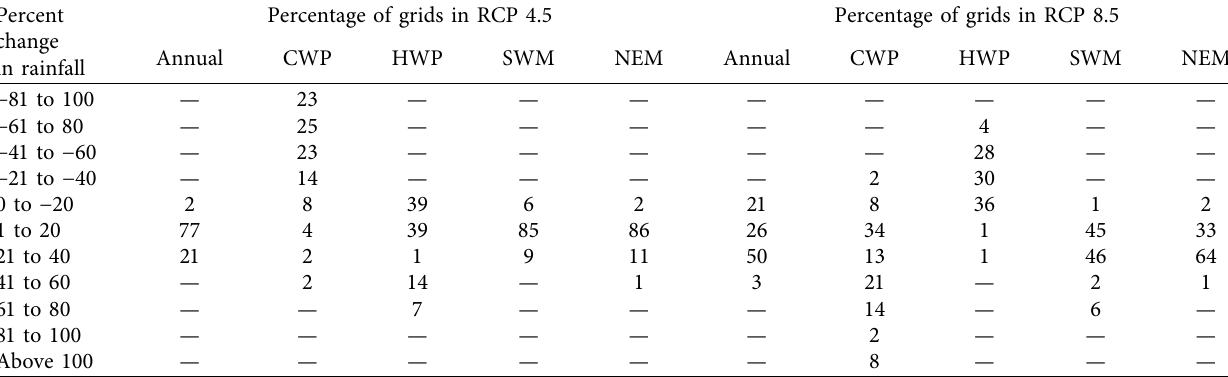
Table 1: Spatial representation of change in annual and seasonal rainfall over Tamil Nadu for the midcentury time period. Percent Percentage of grids in RCP 4.5 Percentage of grids in RCP change in rainfall